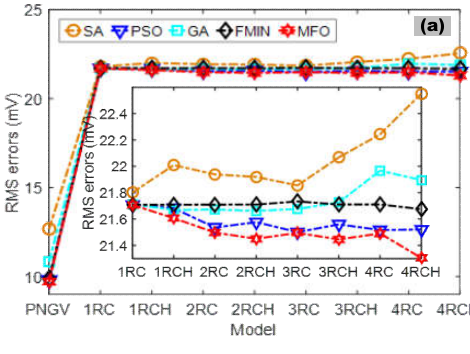
Table 3. Optimization